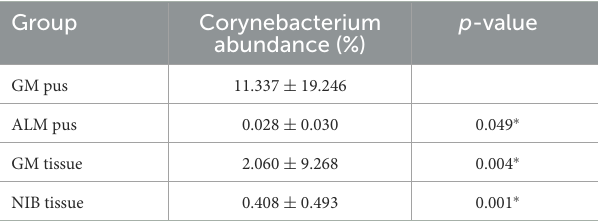
TABLE 3 Comparison between the GM pus group and the other three groups. Group